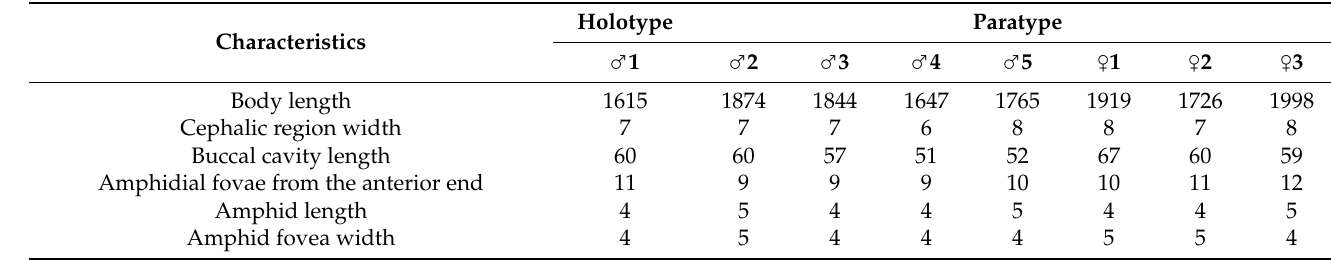
Table 2. Individual measurements for Haliplectus major sp. nov. (in µ